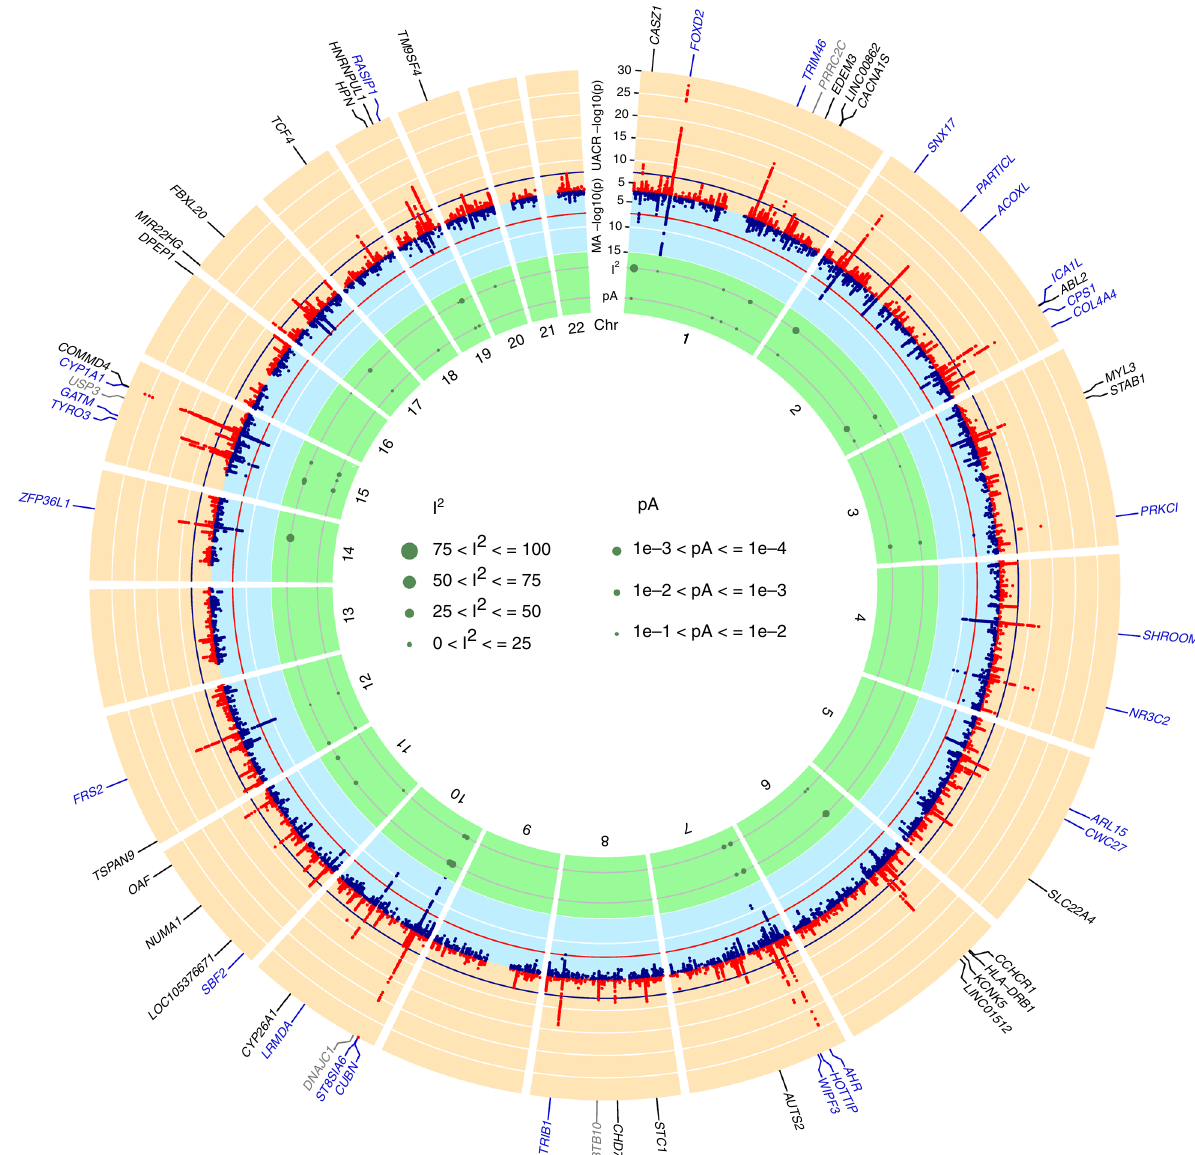
Fig. 1 Genome-wide association results. The circos plot provides an overview of the association results: Red band: – log 10 ( p ) for association in the trans- ethnic meta-analysis of urinary albumin-to-creatinine ratio (UACR), ordered by chromosomal position. The blue line indicates genome-wide signi fi cance ( p = 5 × 10 − 8 ). Black gene labels indicate novel loci, blue labels indicate known loci (known index SNP within ± 500 kb region of current index SNP), gray labels indicate loci not associated with UACR at the nominal signi fi cance level ( p ≥ 0.05) in the 53 CKDGen cohorts without UKBB. Blue band: – log 10 ( p ) for association with microalbuminuria (MA), ordered by chromosomal position. The red line indicates genome-wide signi fi cance ( p = 5 × 10 − 8 ). Green band: measures of heterogeneity related to the UACR-associated index SNPs, where the dot sizes are proportional to two measures of heterogeneity, I² and the – log 10 (p) for heterogeneity attributed to ancestry